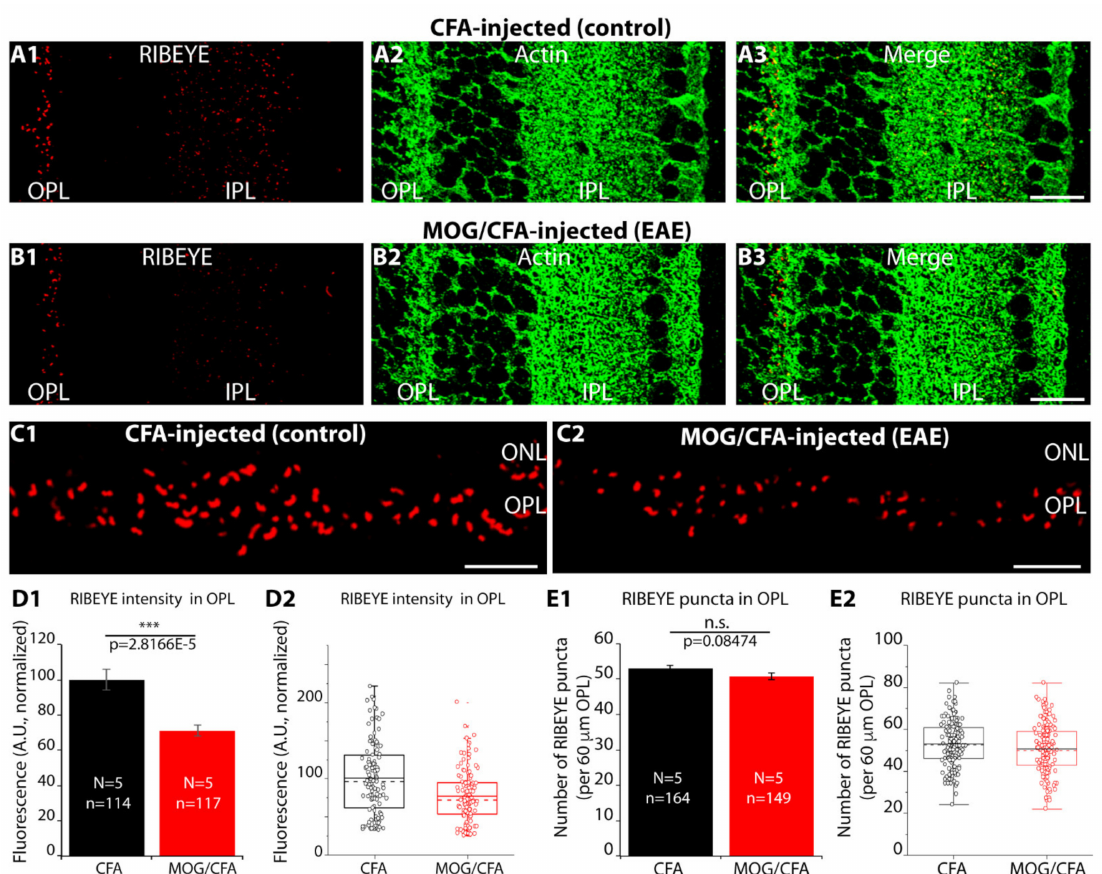
Figure 2. The number of RIBEYE immunolabelled puncta in the OPL is unchanged but decreased in intensity in early pre- clinical EAE. ( A1 – C2 ) 0.5 µ m semi-thin retina sections from CFA (control) and MOG/CFA immunized C57BL/6J mice were processed for immunolabeling on day 9 after the injection. Sections were double-immunolabelled with rabbit polyclonal antibody against RIBEYE (U2656) and mouse monoclonal antibody against actin (Clone C4), as indicated in Figure ( A1 – C2 ). The individual immunosignals from A1 and A2/B1 and B2 were superimposed in A3/B3. ( C1 , C2 ) Magnified view of the OPL immuno-labelled with anti-RIBEYE antibody to visualize the synaptic ribbons. ( D1 , D2 ) Quantification of fluorescence intensity (integrated density) of RIBEYE immunosignals in the OPL. ( E1 , E2 ) Quantification of the number of RIBEYE puncta in the OPL. Values in ( D1 , E1 ) are means ± S.E.M. In the box-and-whiskers plot ( D2 , E2 ) of the data from ( D1 , E1 ), mean values are indicated by solid horizontal lines; median values by dotted horizontal lines. Boxes represent the 25th–75th percentiles of data points and whiskers are equal to 1.5 times of the interquartile range (IQR). Student’s- t -test was applied to determine the statistical significance for puncta count ( E1 ) and Mann–Whitney U-test for fluorescence intensity ( D1 ). Abbreviations: OPL, outer plexiform layer; IPL, inner plexiform layer; ONL, outer nuclear layer; S.E.M., standard error of the mean; N, number of mice; n, number of confocal images analyzed to quantify fluorescence intensity and to count the puncta numbers from retina sections; ***, p ≤ 0.001; n.s., not significant. Scale bars: 10 µ m ( A , B ); 5 µ m ( C